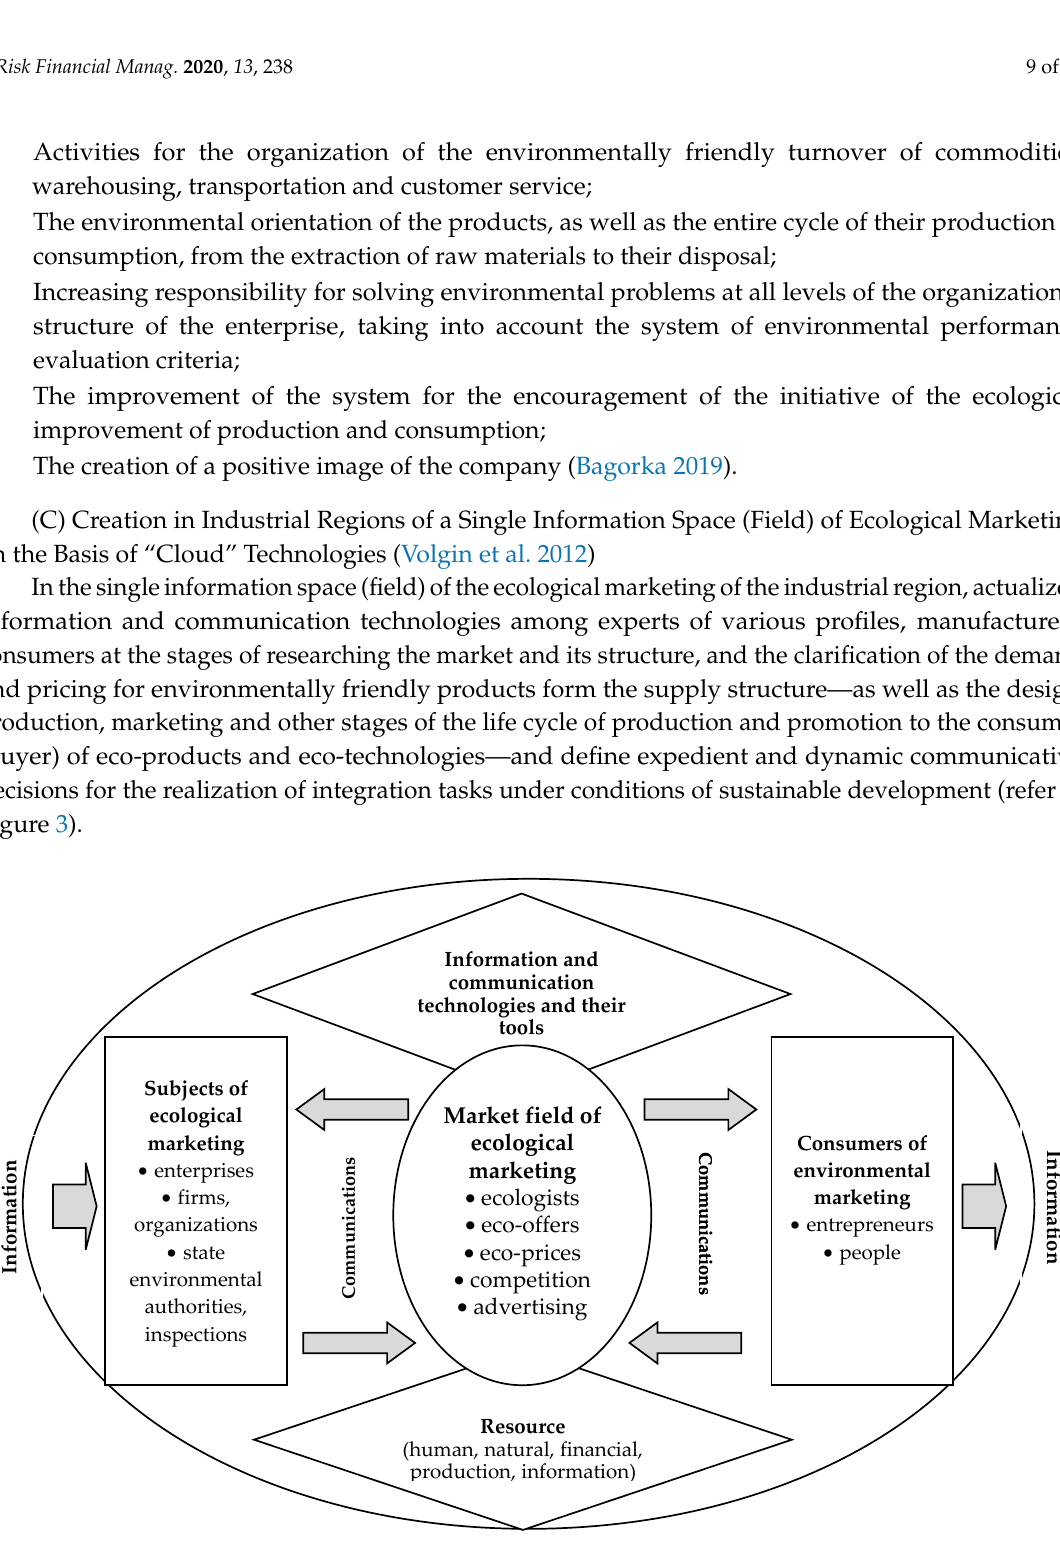
Figure 3. Information space (field) of ecological marketing in industrial regions under conditions of sustainable development (the authors’ scheme).